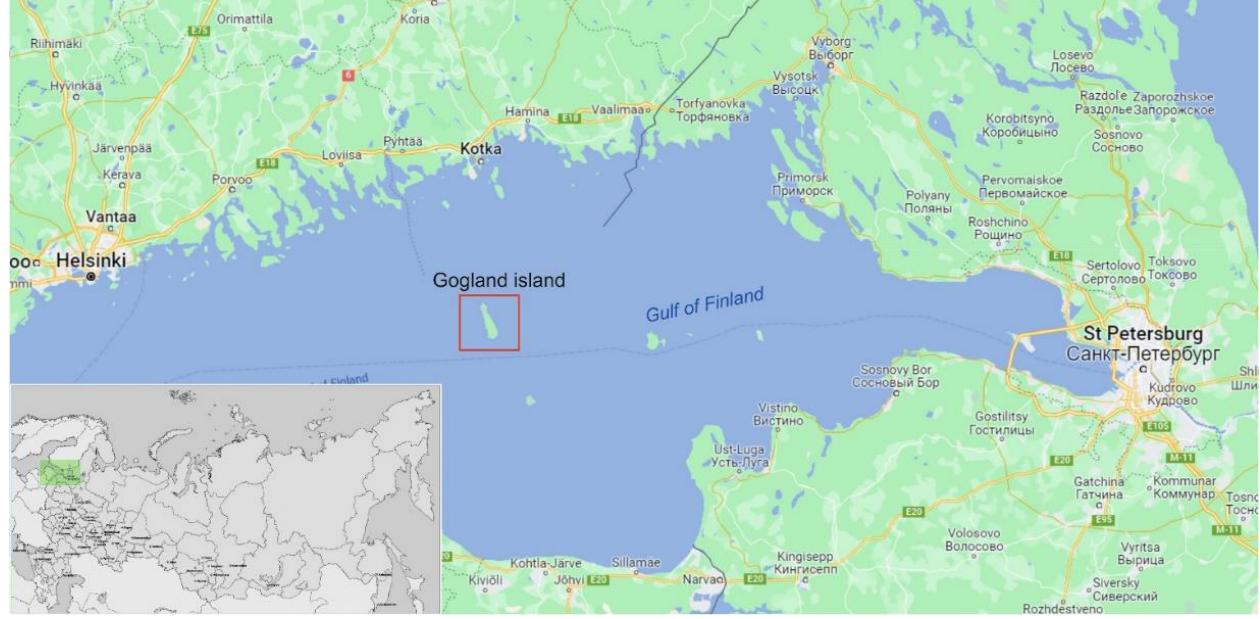
Figure 1. Study object — the location of the island of Gogland in the Gulf of Finland. The following methods were used in order to achieve the study goal: field surveys of the island and laboratory studies.